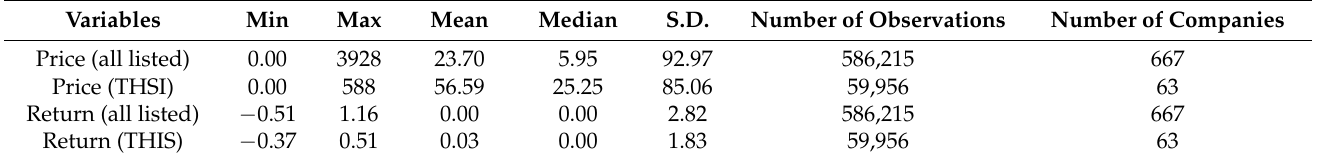
Table 1. Data description for portfolio formation variables.